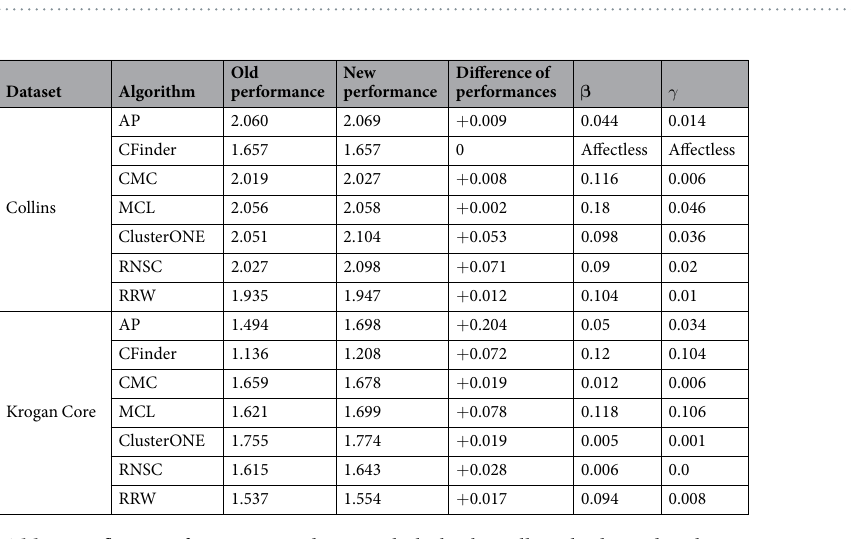
New performance